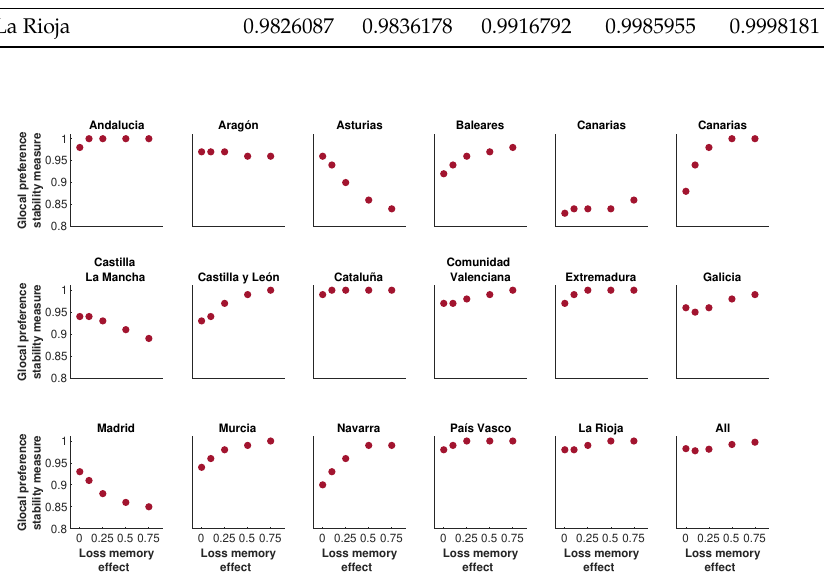
Figure A4. Graphic illustration of the global decision stability measures for Question 1 obtained for each